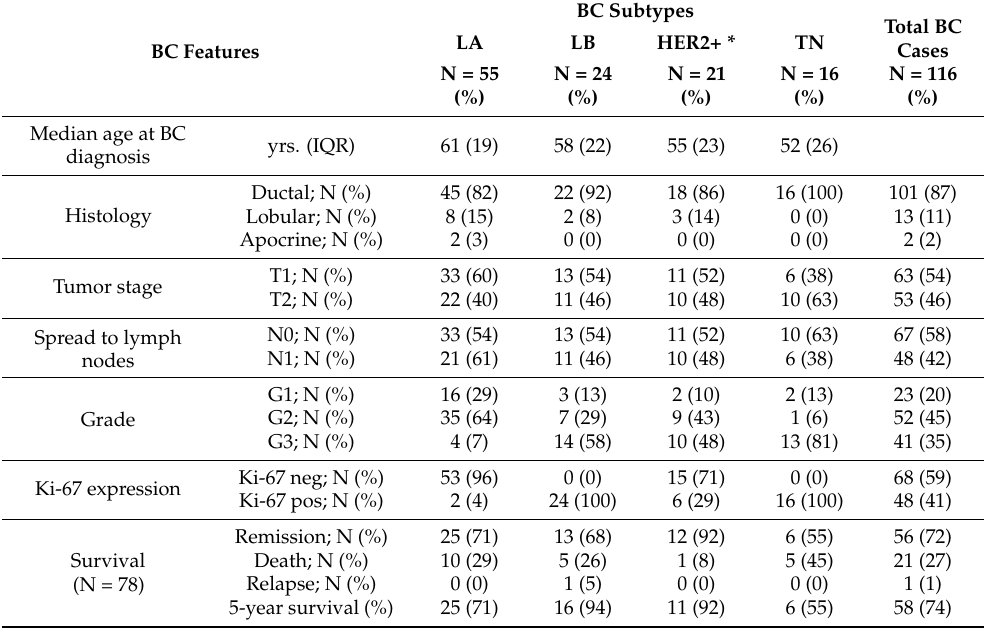
Table 3. Demographic and clinical–pathological characteristics of breast cancer (BC) patients dis- tributed by breast cancer (BC)